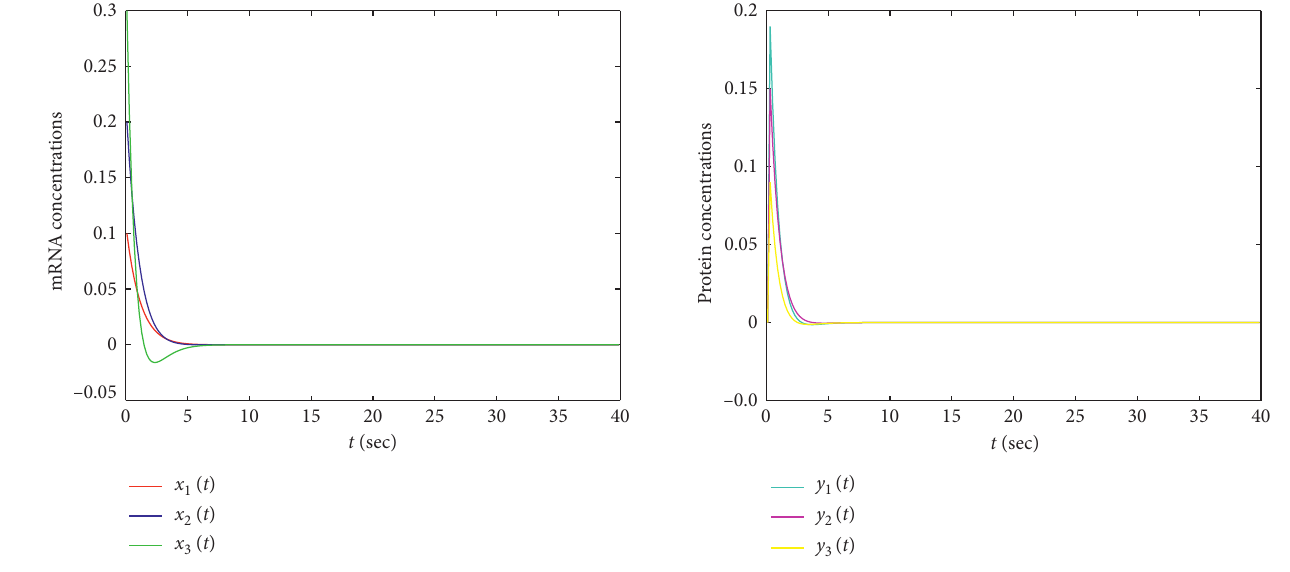
Figure 4: The trajectories of y ( t ) in Example 2. Figure 3: The trajectories of x ( t ) in Example